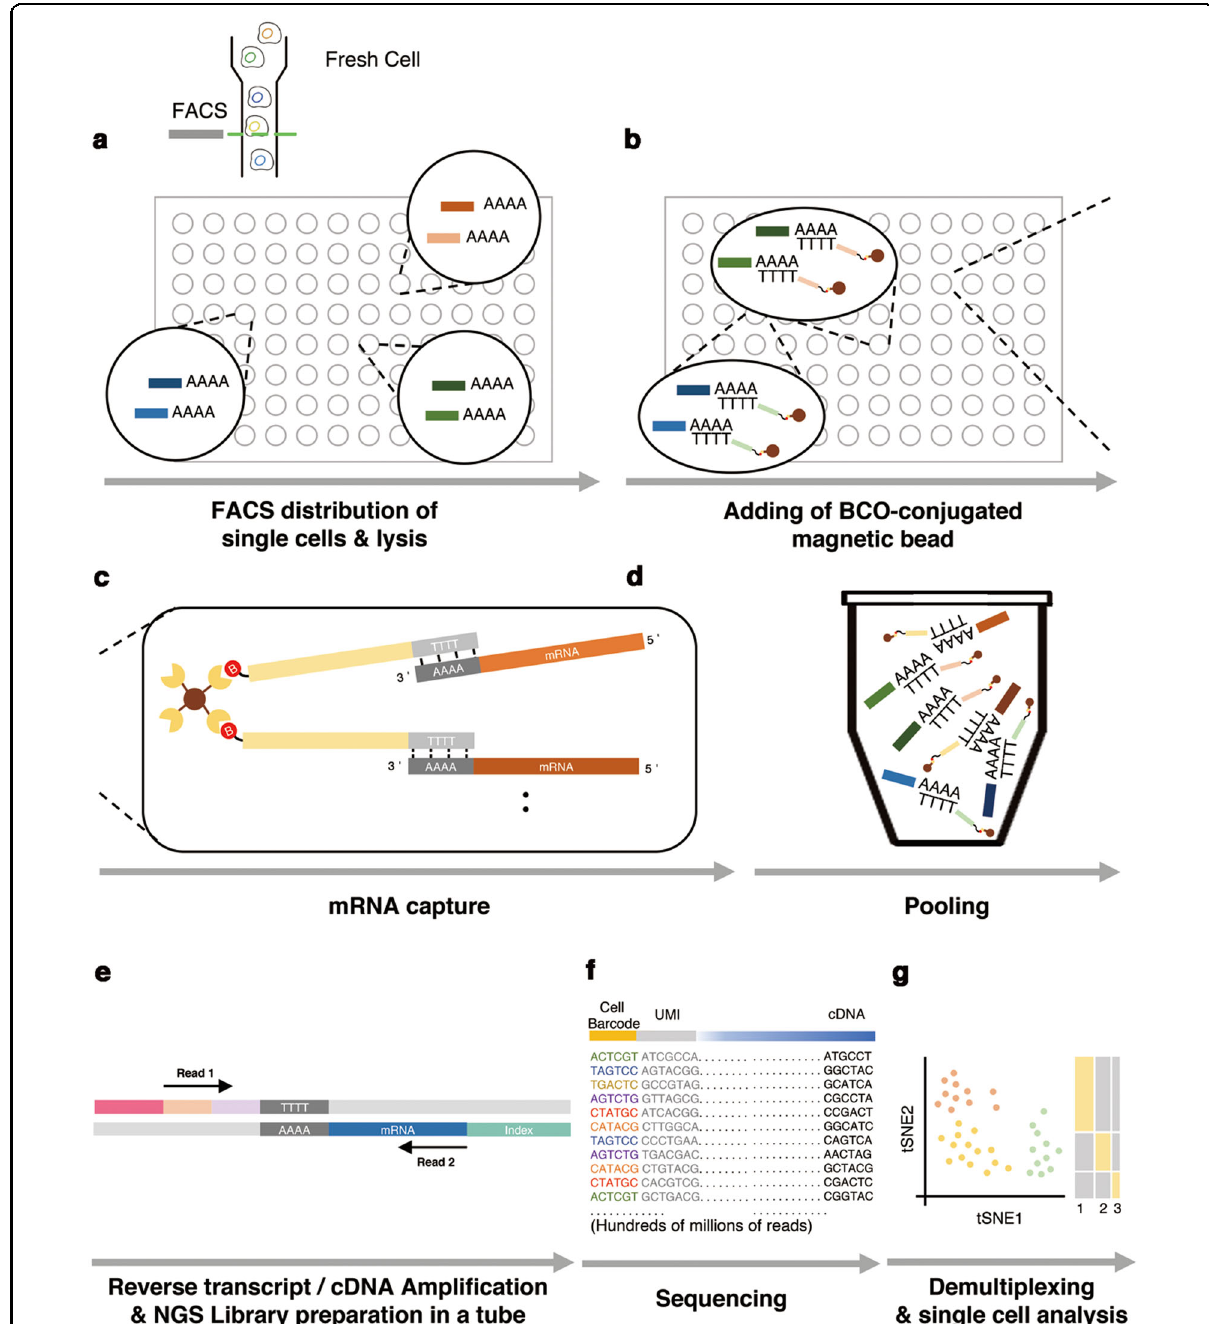
Fig. 1 Principle and work fl ow of MAPS-seq. a Cells were dispensed into 96-well plates using a FACS sorter. b The binding reaction of streptavidin beads with biotin forms strong noncovalent bonds. Streptavidin beads conjugated with biotinylated cell-speci fi c barcode oligos (BCOs) are added to each well. c Streptavidin beads conjugated with BCOs capture the poly-A sequence of mRNA transcripts. d All wells are pooled into a single tube. e Reverse transcription, cDNA ampli fi cation, and NGS library preparation were performed as in the standard Drop-seq method. f Sequencing was conducted using an Illumina 75 bp NGS system. “ Read 1 ” contains information about the cell barcode and UMI; “ Read 2 ” contains information about the transcript. g Data are demultiplexed and assigned to the originating cell. After postprocessing, these data can be expressed in various